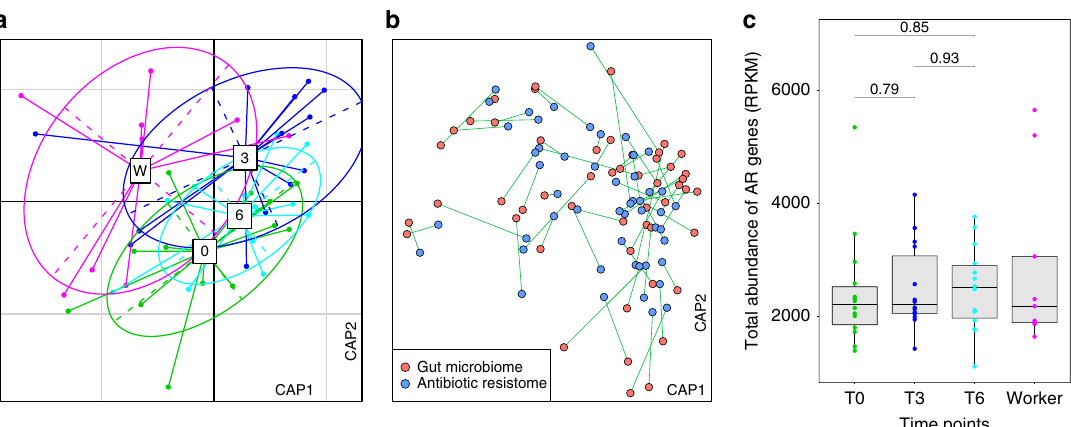
Fig. 2 Change in the gut antibiotic resistomes following environmental exposure. a Distance-based redundancy analysis (dbRDA) plot of the gut antibiotic resistomes of students ’ samples at time points 0 (red), 3 (green) and 6 (blue), and workers ’ samples. Lines connect samples from the same time point, and colored circles indicate the samples near the center of gravity for each time point. The fi rst two constrained principal coordinates are shown (CAP1 2.8% variance explained, CAP2 1.6% variance explained). b Procrustes analysis connecting the microbiomes and resistomes of gut microbiota. c total abundance of the antibiotic resistance genes in students ’ samples at time points 0, 3, and 6, and workers ’ samples. Box plots show the distribution of students ’ samples ( n = 14 biologically independent samples per timepoint) (boxes show medians/quartiles; error bars extend to the most extreme values within 1.5 interquartile ranges). P > 0.05; Student ’ s t -tests (paired two-sided test between the students ’ samples at time points 0, 3, and 6). P -values are multiple hypothesis test corrected using Benjamini – Hochberg (FDR) correction. Underlying data are provided in the Source Data fi